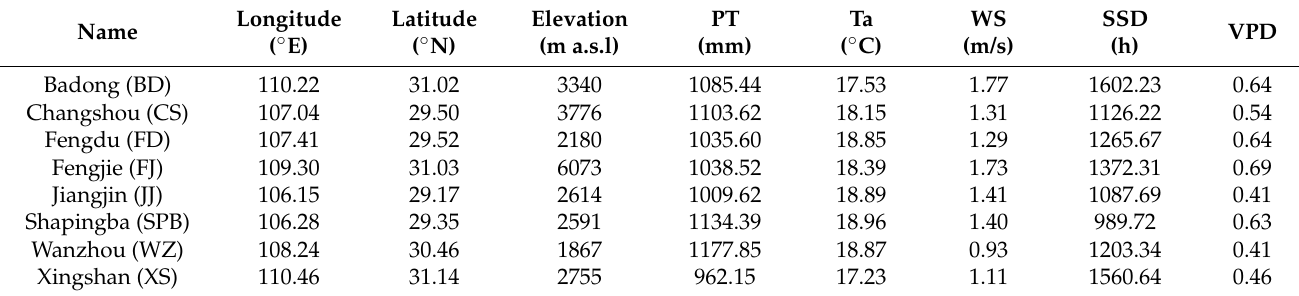
Table 2. Detailed information of the studied meteorological